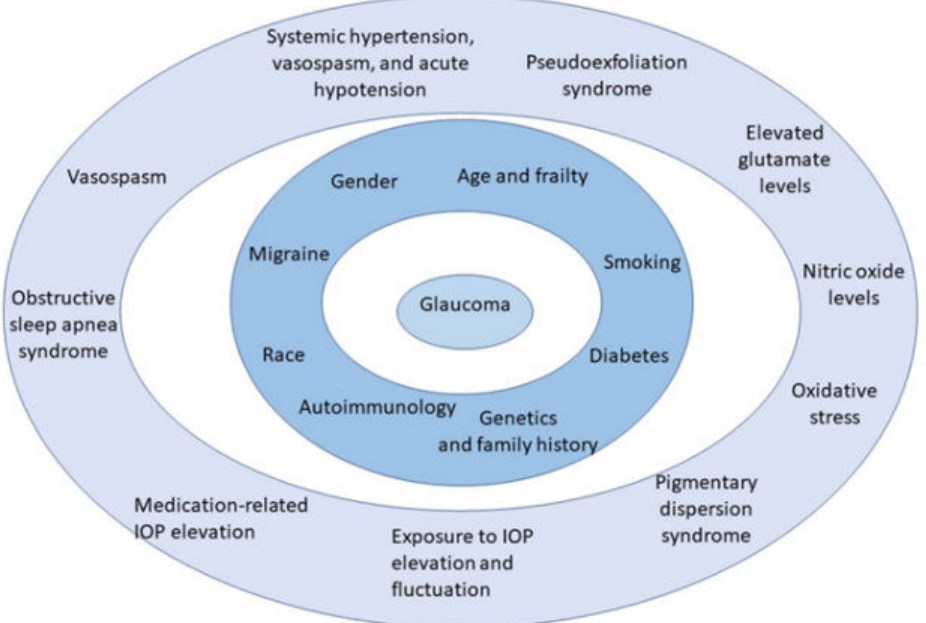
Figure 1. Risk factors influencing glaucoma